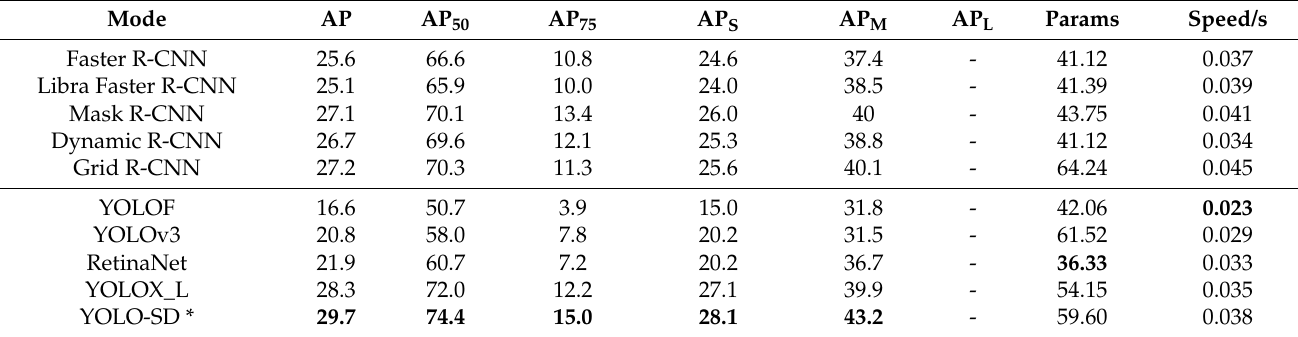
Table 5. Results of various models on LS-SSDD-v1.0.